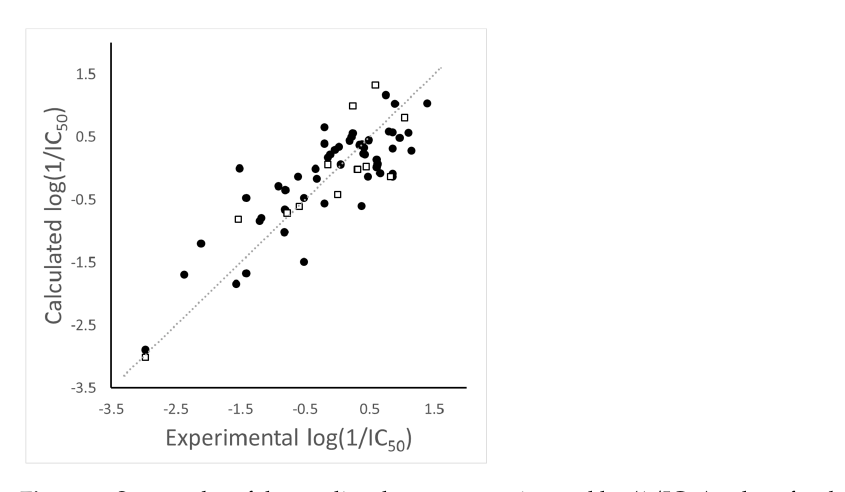
Figure 6. Scatter plot of the predicted versus experimental log(1/IC 50 ) values for the training set ( ● ) and the test set ( □ ) using the 2D autocorrelation